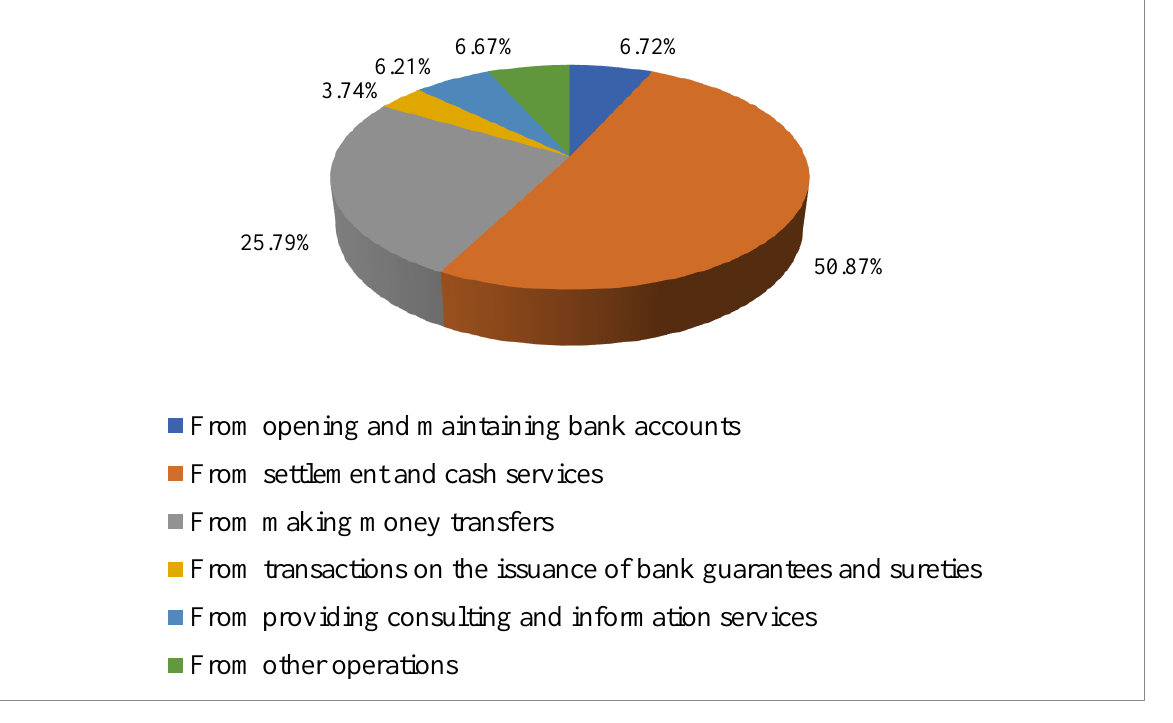
Figure 4. The structure of commission income of “Sberbank of Russia” for 2021 (Sberbank of Russia Financial Results Report for 2021 n.d.).